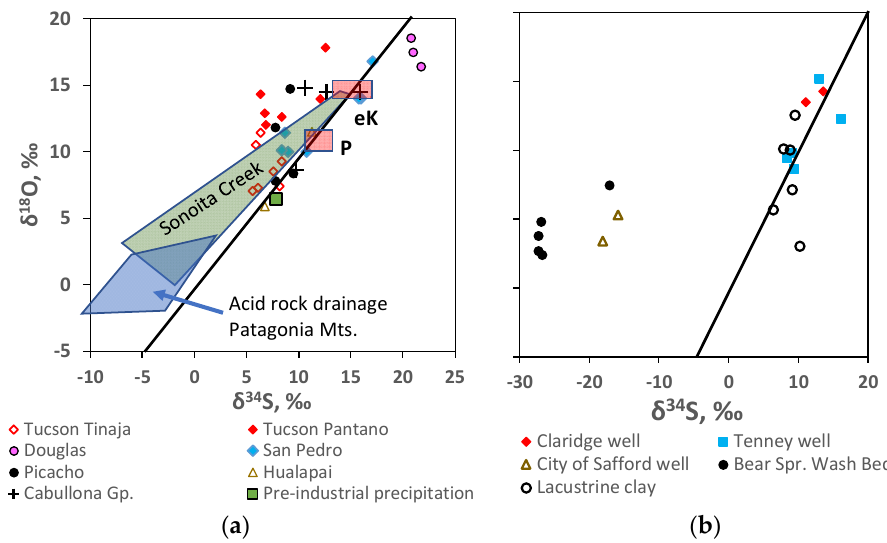
Figure 5. Plots of δ 18 0 (sulfate) vs. δ 34 S for sulfate minerals in evaporites and lacustrine sediments. ( a ) Arizona basins (except Safford) and Cabullona Group, Sonora; also shown are data for Sonoita Creek base flow and riparian groundwater, and acid rock drainage from the Patagonia Mountains (blue-shaded area). ( b ) Safford Basin. Black diagonal lines are δ 34 S = δ 18 0. Data sources: Cabullona Group [81], Hualapai Basin [16], sulfate in pre-industrial precipitation [66], Sonoita Creek and Patagonia Mountains [63,69,70], other locations, this study.